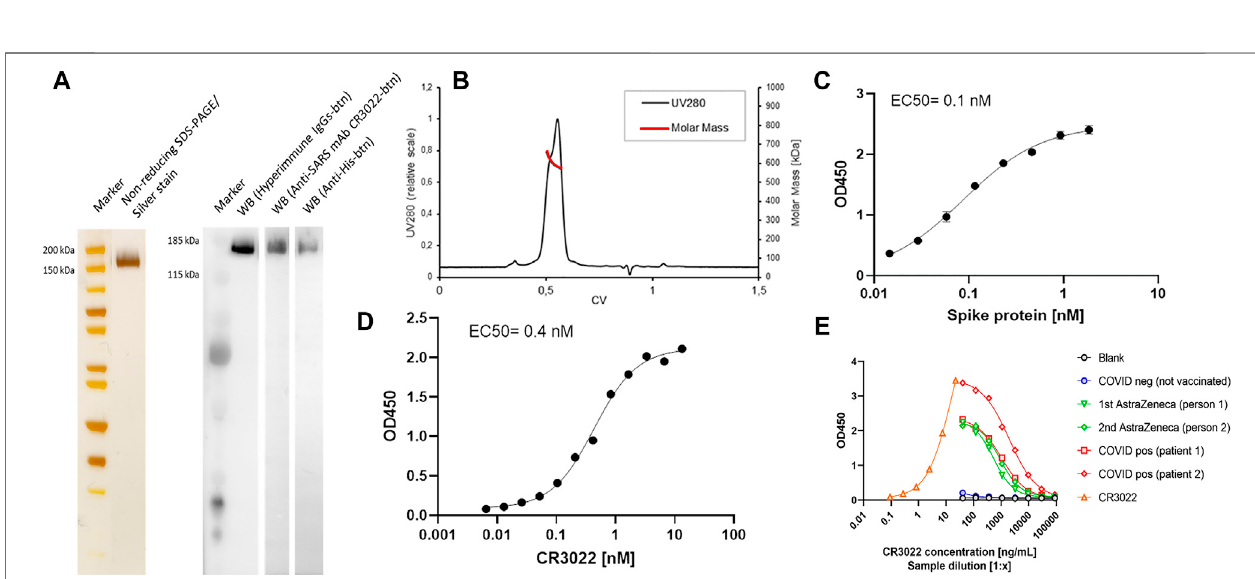
FIGURE 8 | Non-reducing SDS-PAGE of the pure CSs spike protein preparation gives a single intense band (2 µg loaded) after silver stain and various Western blotting setups using hyperimmune IgG, anti-SARS mAb CR3022, or anti-His antibodies (A) . Analytical SEC/MALS-HPLC by aSuperose6 increase 10/300 GL column (Cytiva) indicates the high purity of the IMAC preparation with the characteristic double peak of the spike protein (B) . The molar mass of the trimeric spike is about 610 kDa (MALS signal) and elutes at 0.55 CV. The purity of the trimer fraction is > 90%. Determination of af fi nity (EC50) of spike protein to ACE2 (C) : ACE2 was coated on ELISAplates,and theboundCSsspike protein wasdetected byanti-His-btn/SA-HRPconjugates.Thepuri fi edspike protein preparation showedhigh af fi nity to the anti-SARS mAb CR3022 (D) : Coating: 5 μ g/ml spike protein and detection with CR3022-btn/SA-HRP conjugates. A sigmoidal non-linear four-parametric log modelwasusedforthecalculationoftheEC50.Thepuri fi edspikeproteinwasappliedtoaserologicalELISAsetuptodetectspike-speci fi cantibodiesinCOVID-positive individuals or individuals vaccinated with one or two doses of the AstraZeneca vaccine (E) : coating 5 μ g/ml of spike protein and detection with anti-huGamma-HRP.